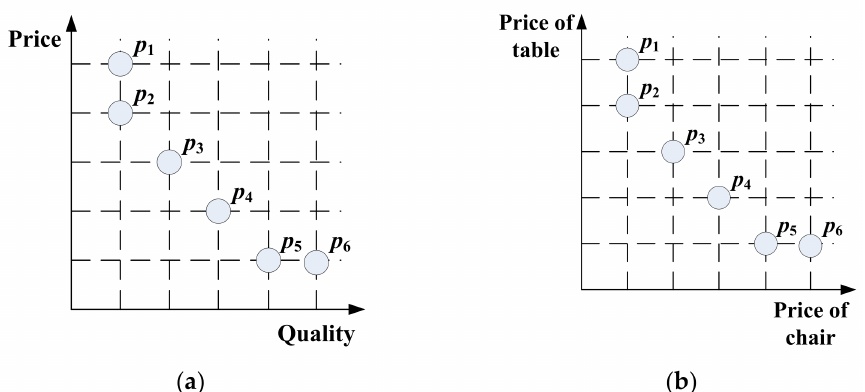
Figure 2. Population distribution for multi-objective optimization (MOO) and multi-task optimiza- tion (MTO) problems. ( a ) Multi-objective optimization problem finding a cheap and fine table. ( b ) Multi-task optimization problem finding a cheap table and a cheap chair concurrently.